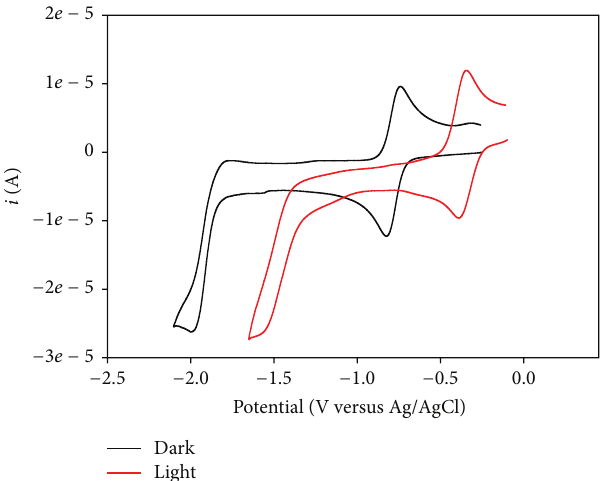
Figure 5: Cyclic voltammetry of 0.20 mM Co(TPP)Cl in 0.1M [Bu 4 N][BF 4 ]-95% MeCN+ 5% DMF, scan rate 100 mVs −1 at p-type Si electrode in dark and at illuminated p-type Si electrode under Ar.